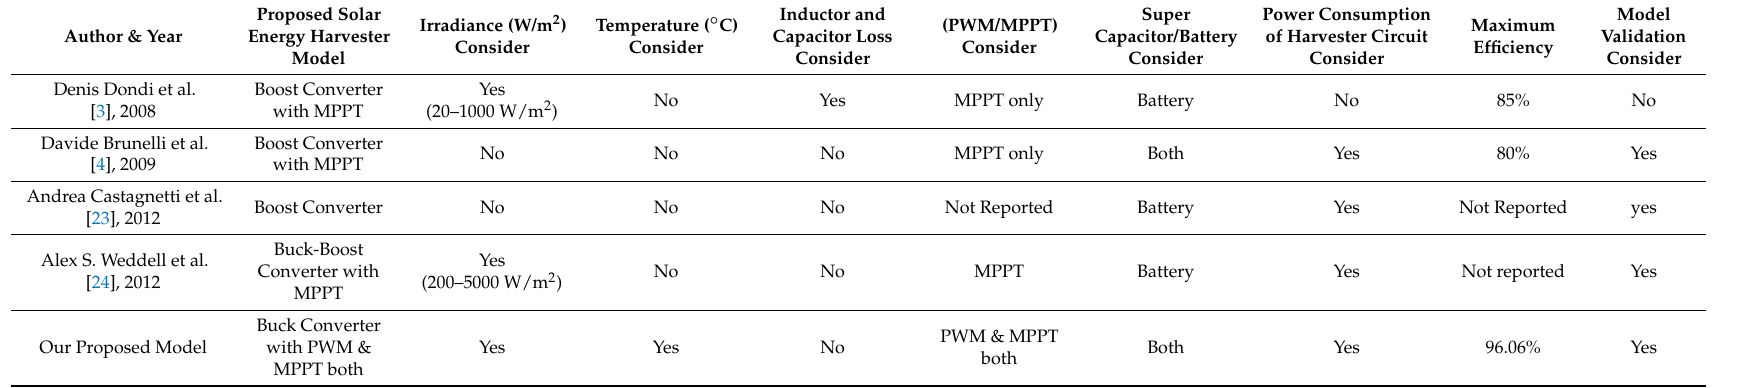
Table 4. Comparison of existing Solar Energy Harvesting models for WSN